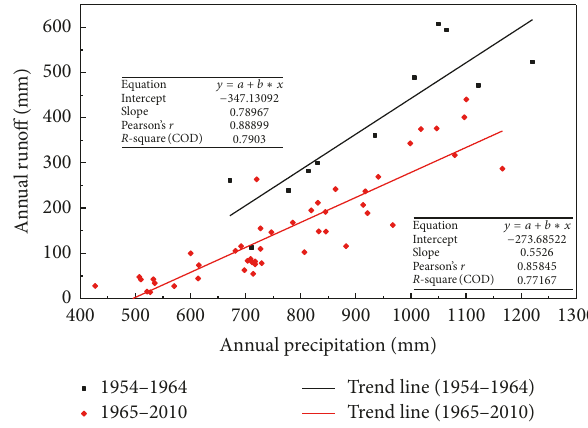
Figure 7: Correlation analysis of precipitation and runoff for pre/postchange